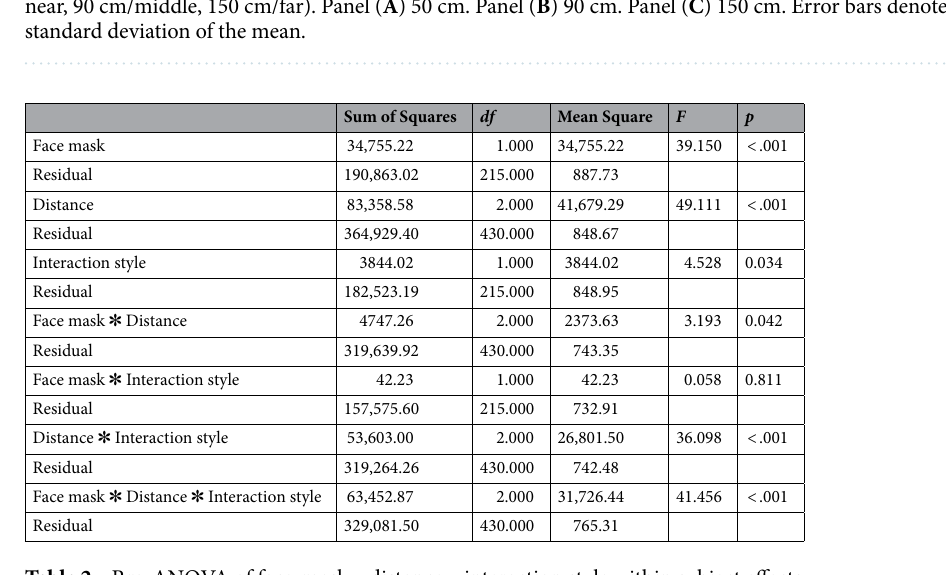
Table 2. Rm-ANOVA of face-mask x distance x interaction style within subject